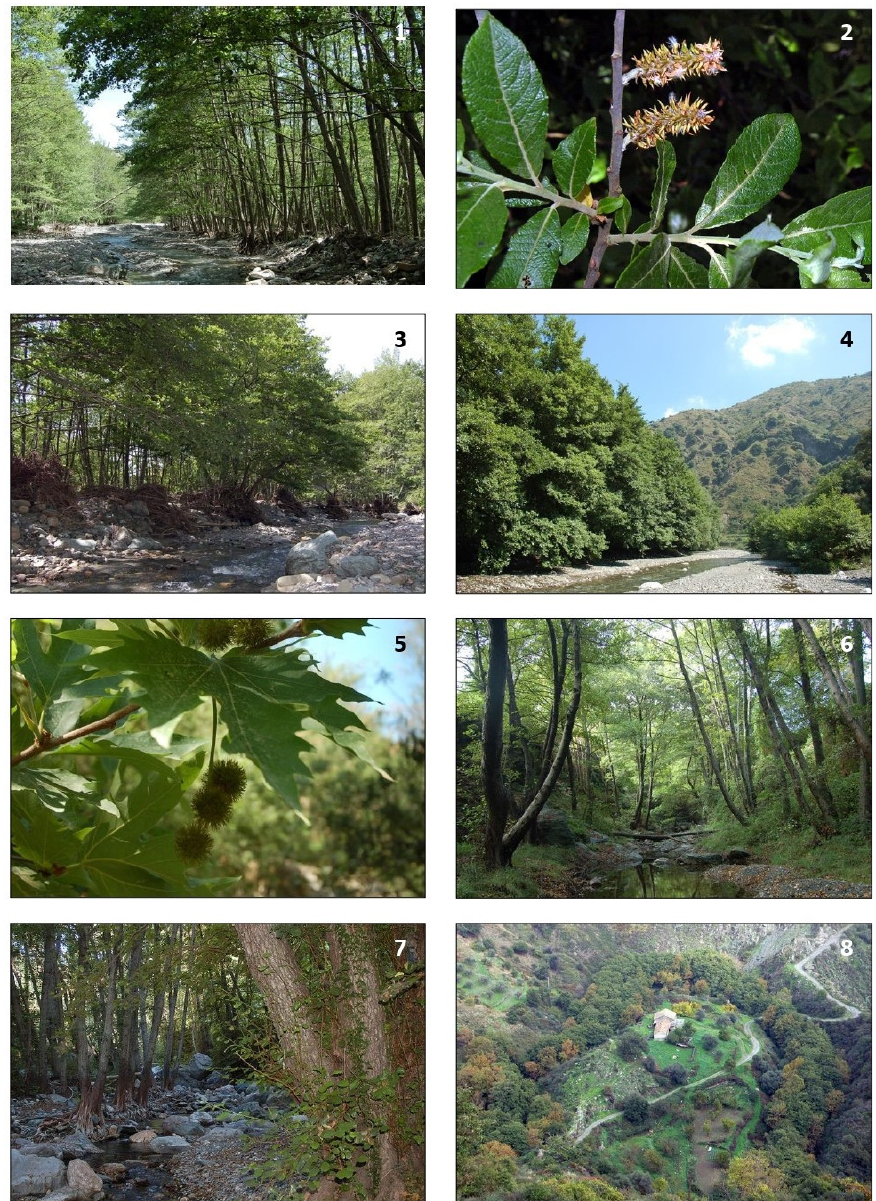
Figure 6. Plant communities and diagnostic species of the Alnus glutinosa riparian woodlands in Sicily: ( 1 ) Platano-Alnetum glutinosae (Fiume Alcantara, Tyrrhenian side of the Peloritani Mountains); ( 2 ) Salix gussonei , diagnostic endemic species of the Platano-Alnetum glutinosae ; ( 3 ) Platano-Alnetum glutinosae (Fiume Alcantara—Ionic side of the Peloritani Mountains); ( 4 ) Platano-Alnetum glutinosae (Fiume Mela—Tyrrhenian side of the Peloritani Mountains); ( 5 ) Platanus orientalis , characteristic species of the Platano-Alnetum glutinosae ; ( 6 – 8 ) Platano-Alnetum glutinosae (Antillo—Monti Peloritani) (Photo credits: L. Gianguzzi ( 1 – 8 ).